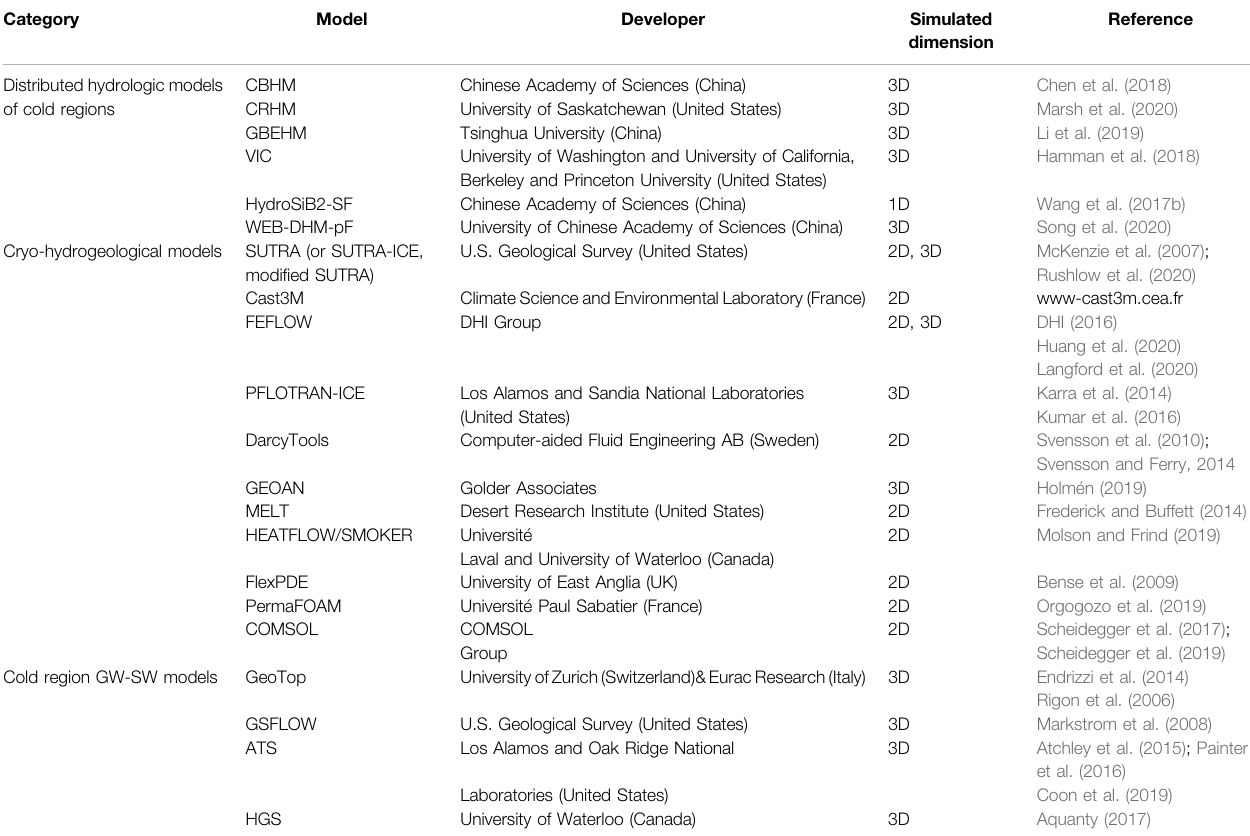
TABLE 1 | Summary of cold region integrated hydrologic models.